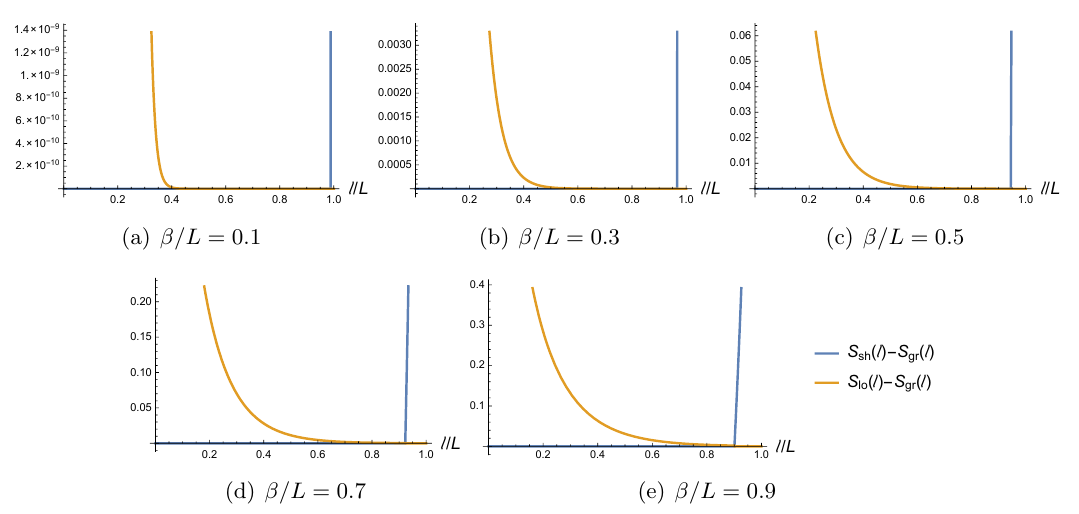
Figure 5 . In the large c limit, the leading order entanglement entropy of a short interval (2.29) and a long interval (2.31). We use the holographic entanglement entropy (2.2) as the benchmark to compare. The (cid:12)gures are plotted in unit of c=